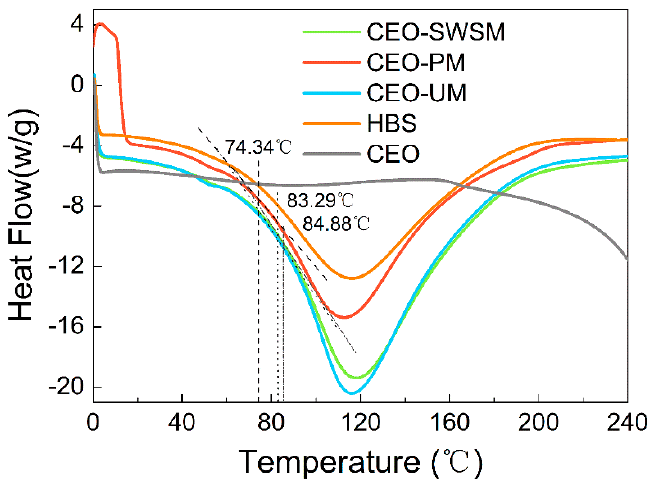
Figure 5. Differential scanning calorimeter (DSC) heating thermograms of pure HBS, CEO, and the microcapsules synthesized via saturated aqueous solution method (CEO-SWSM), molecular inclusion method (CEO-PM), and ultrasonic method (CEO-UM).